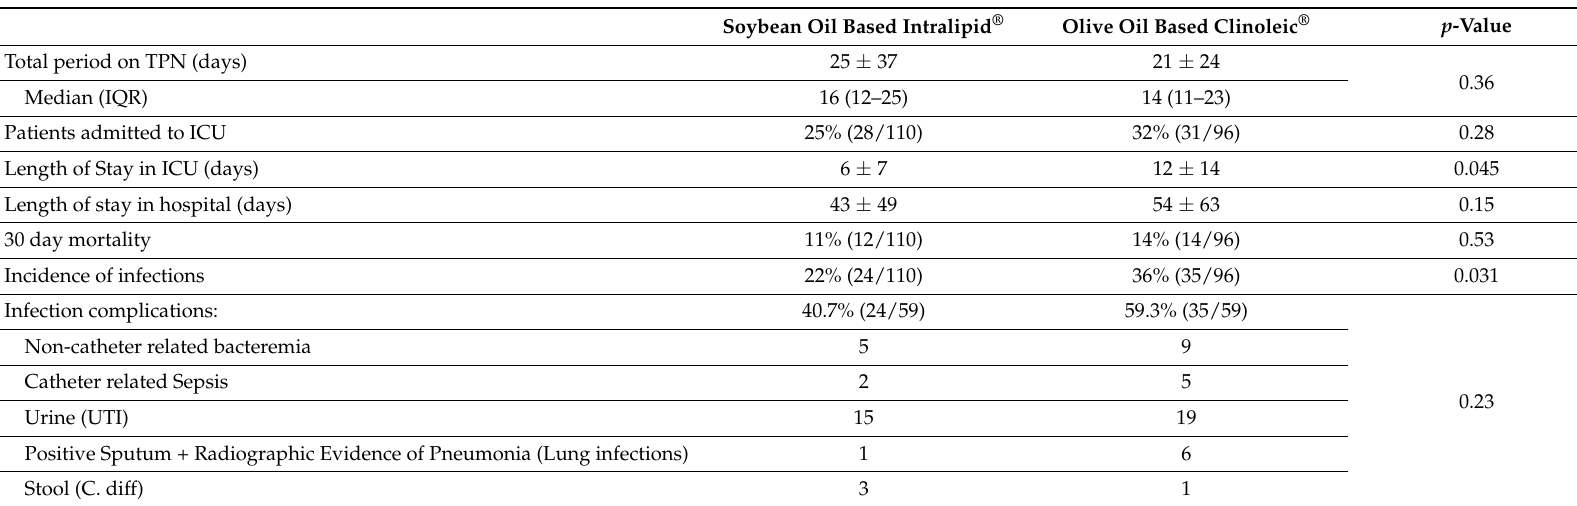
Table 4. Other outcomes